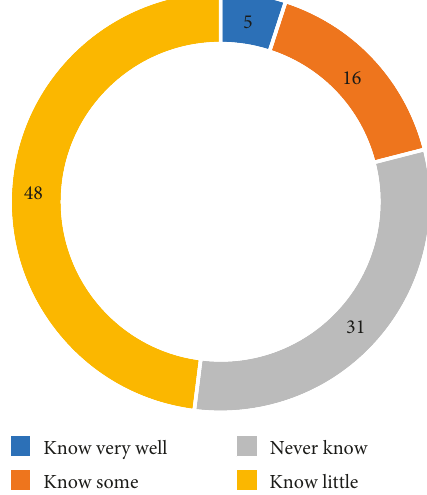
Figure 2: The cognition of video teaching resources.